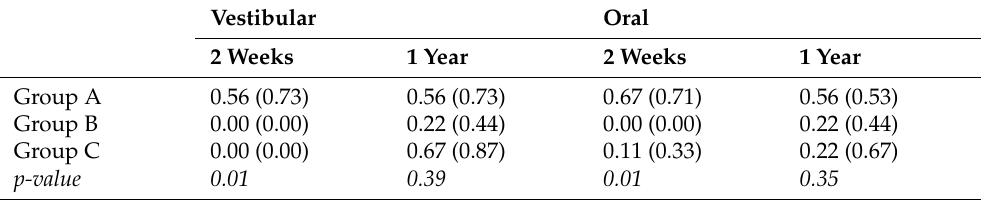
Table 6. Temporal analysis of bleeding index in patients with different types of implant suprastructures.